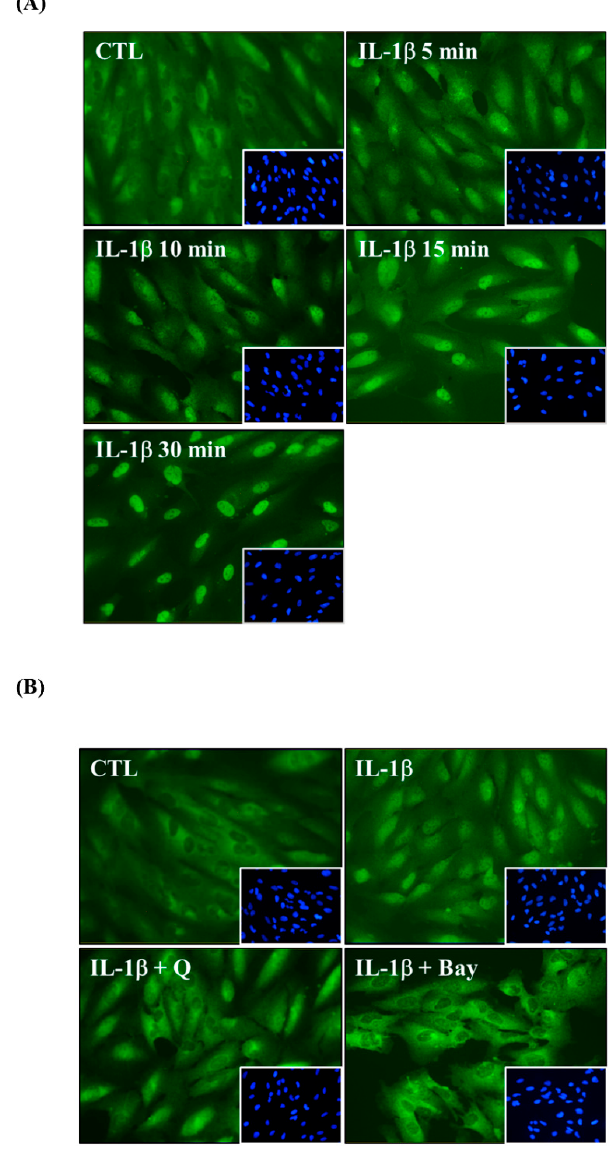
Figure 8. Quercetin attenuates NF- κ B p65 translocation in IL-1 β -stimulated ARPE-19 cells. Immunofluorescence staining was used to evaluate NF- κ B p65 translocation in ( A ) ARPE-19 cells stimulated with 1 ng/mL IL-1 β for the indicated time, and ( B ) ARPE-19 cells pretreated with 20 μ M quercetin or 5 μ M Bay 11-7082 for 1 h prior to activation with 1 ng/mL IL-1 β for 10 min. The image is representative of the results of four independent experiments. Green : the location of the p65 subunit; Blue : DAPI for nuclear